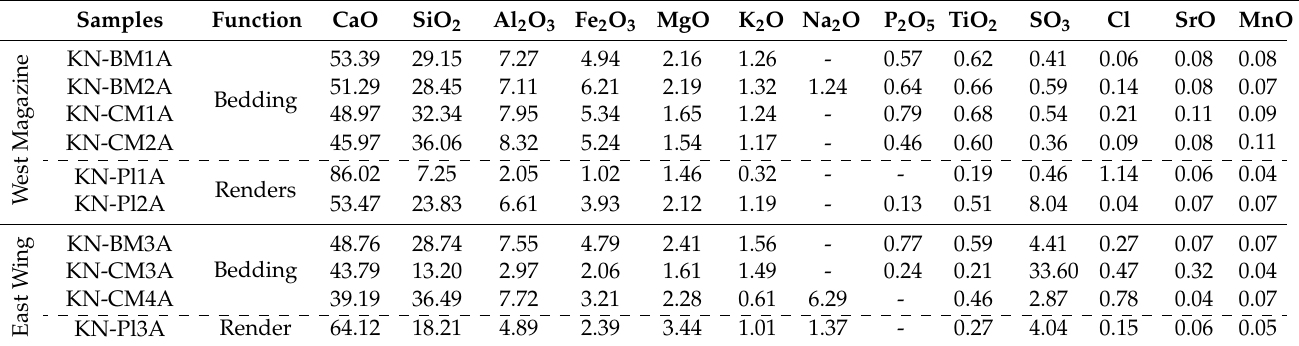
Table 3. Chemical composition of mortar samples from the Palace of Knossos, obtained by WDXRF (wt%) (“-“ not detected).